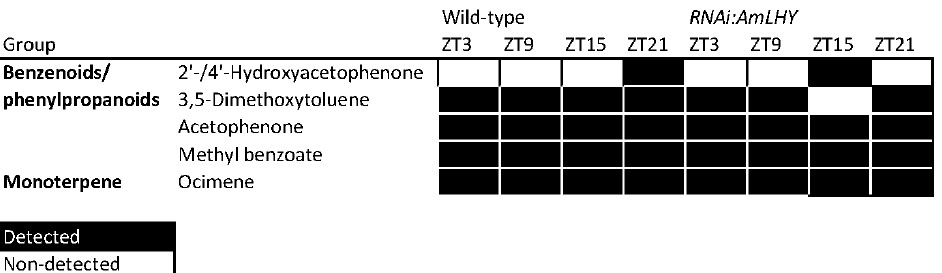
Figure 8. Constitutive scent profile of wild-type and transgenic RNAi:AmLHY snapdragons at four different time-points, denoted as ZT (zeitgeber time) 3, 9, 15 and 21. ZT0 represents the time of lights on and ZT12, lights off. We set minQuality to 80% (NormalizeWithinFiles function). Constitutive profile includes VOCs present in 100% of analyzed samples. Volatiles are listed according to their class. Black indicates detected compounds and white, non-detected compounds .